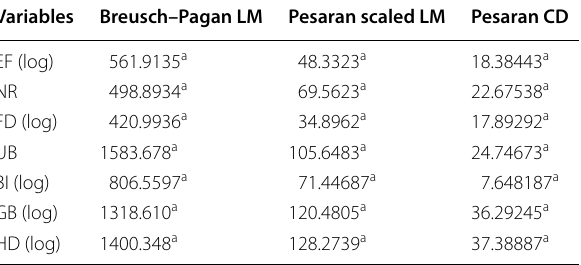
Table 6 Westerlund cointegration